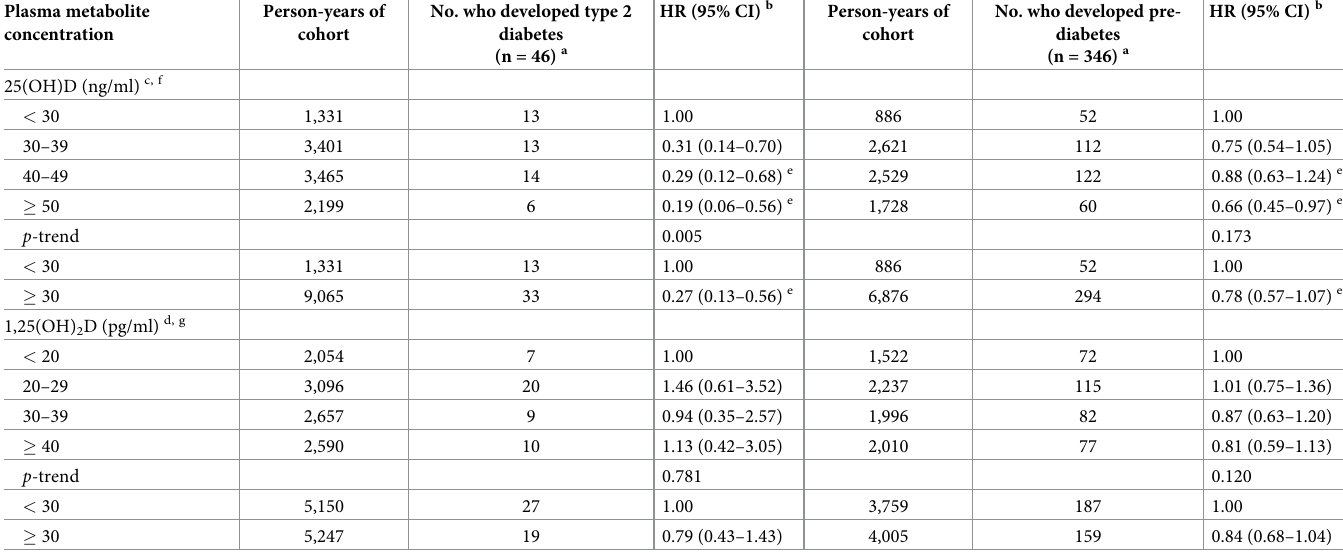
Table 3. Hazard ratios with 95% confidence intervals of type 2 diabetes mellitus (DM) incidence by categories of plasma vitamin D metabolite concentrations in the Rancho Bernardo cohort, 1997–1999. Plasma metabolite